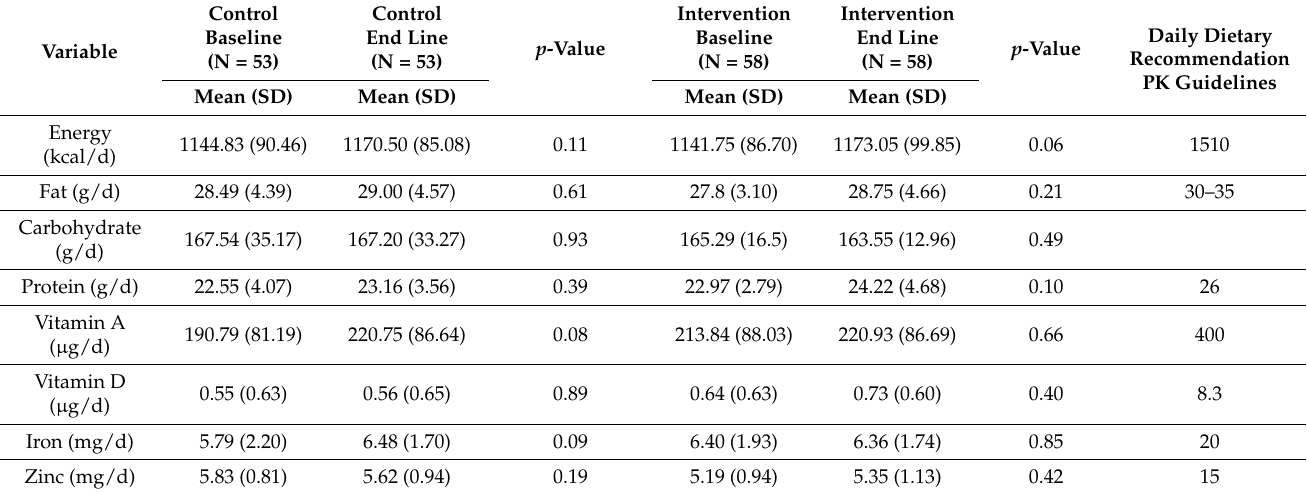
Table 4. Daily dietary nutrient intake during the trial.